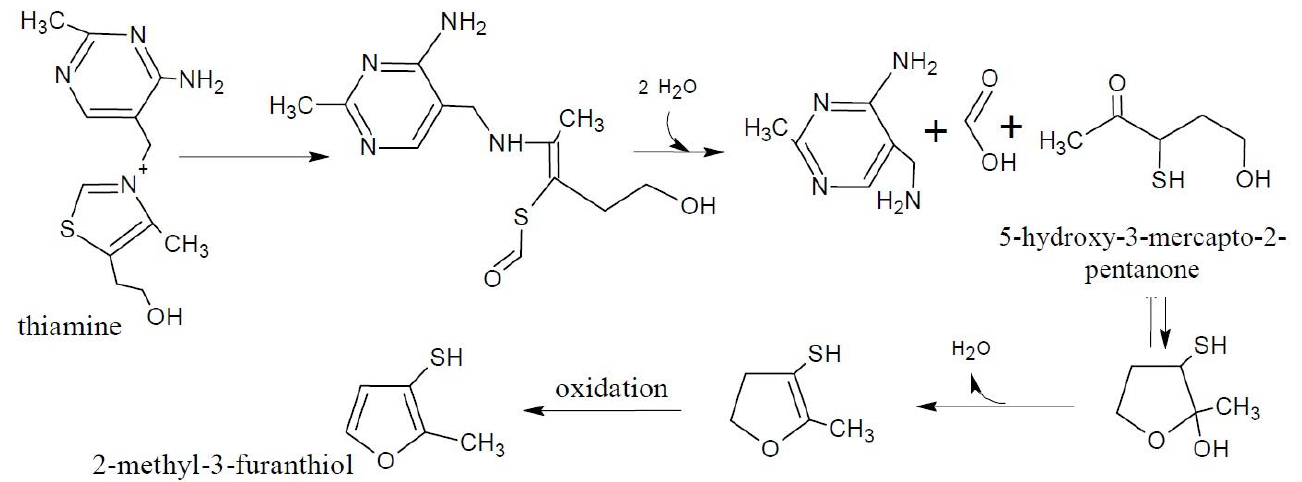
Figure 2. Thiamine degradation to the formation of 2-methyl-3-furanthiol via 5-hydroxy-3-mercapto-2-pentanone. Reprinted from Resconi et al. (2013) [15] with permission from MDPI under the terms of the CC BY license.